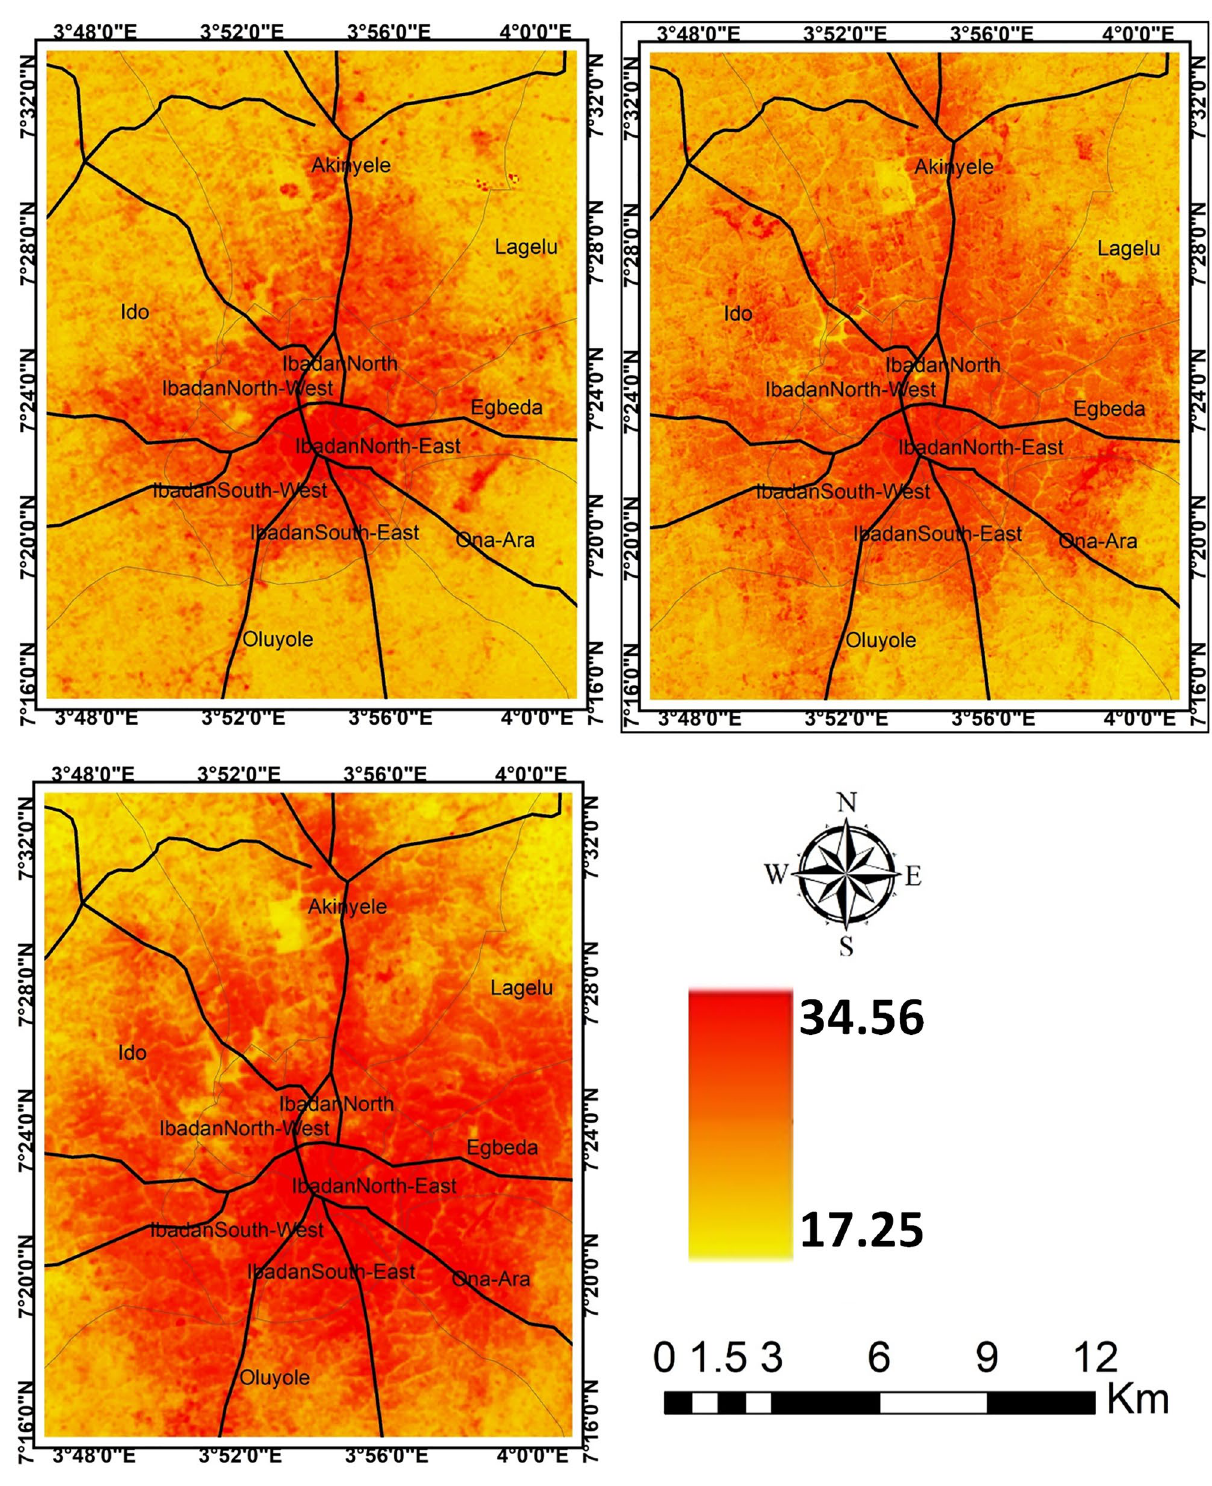
Figure 4. Land surface temperature intensity over Ibadan from 1984 to 2019. The figure was generated using Quantum GIS (QGIS 3.4) software (https:// qgis. org/ en/